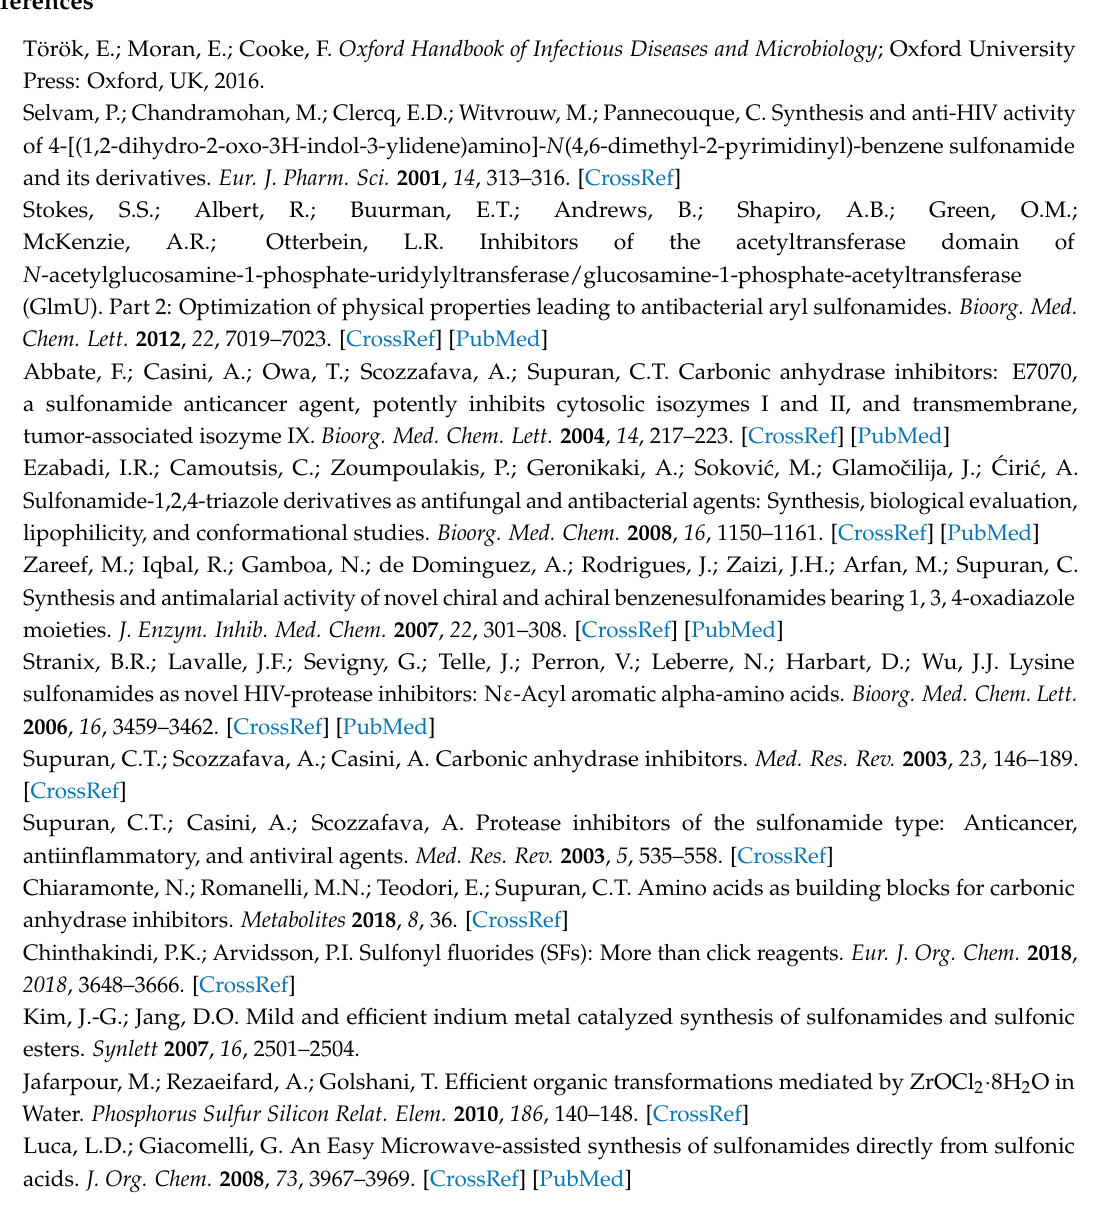
Figure S1: 1 H NMR and 13 C for compound 4a , Figure S2: 1 H NMR and 13 C for compound 4b ; Figure S3: 1 H NMR and 13 C for compound 4c ; Figure S4: 1 H NMR and 13 C for compound 5a ; Figure S5: 1 H NMR and 13 C for compound 5b ; Figure S6: 1 H NMR and 13 C for compound 5c ; Figure S7: 1 H NMR and 13 C for compound 7a ; Figure S8: 1 H NMR and 13 C for compound 7b